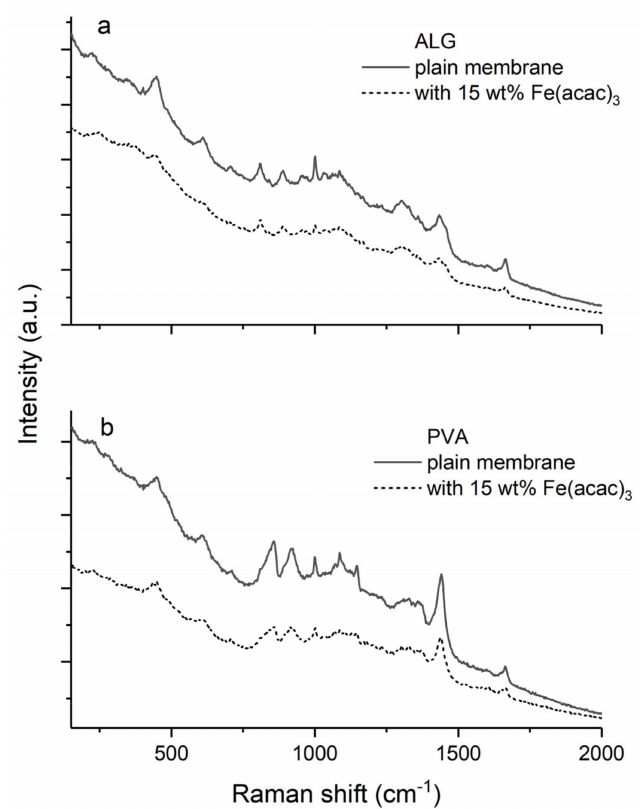
Figure 2. Raman spectra of plain and loaded with 15 wt% of tris(acetylacetonato) iron(III) membranes: ( a ) plain ALG membrane (solid line) and hybrid ALG membrane filled with Fe(acac) 3 (dotted line); ( b ) plain PVA membrane (solid line) and hybrid PVA membrane filled with Fe(acac) 3 (dotted